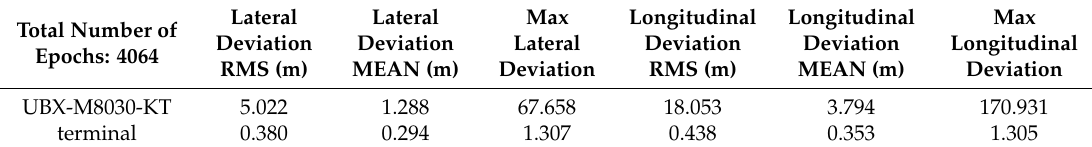
Figure 7. The trajectories of vehicle on roads with noise barrier (the green trajectory uses only satellite positioning, and the red trajectory uses both satellite positioning and inertial navigation, while the blue one is obtained from the POS 620 unit). 4.2. Kernel Positioning Driver